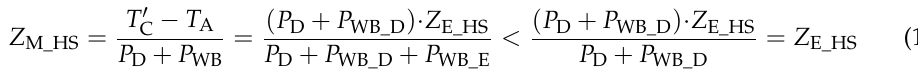
2.2. Fault Detection Method of IGBT Bond Wire Fatigue Based on Heatsink Thermal Resistance